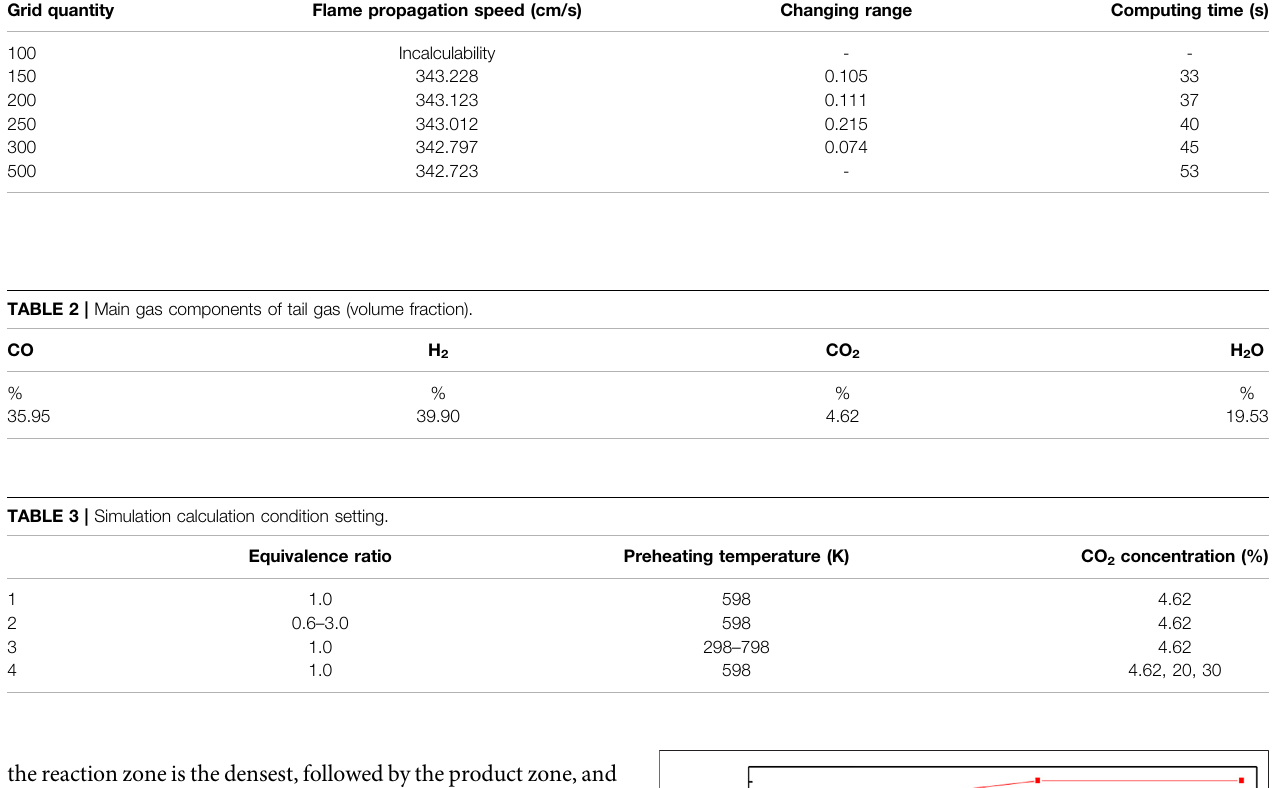
TABLE 1 | Test of optimal number of grids. Grid quantity Flame propagation speed (cm/s)